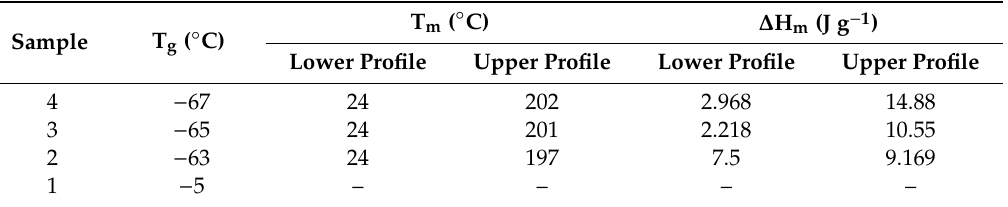
Figure 2. DSC second scans of the studied samples.